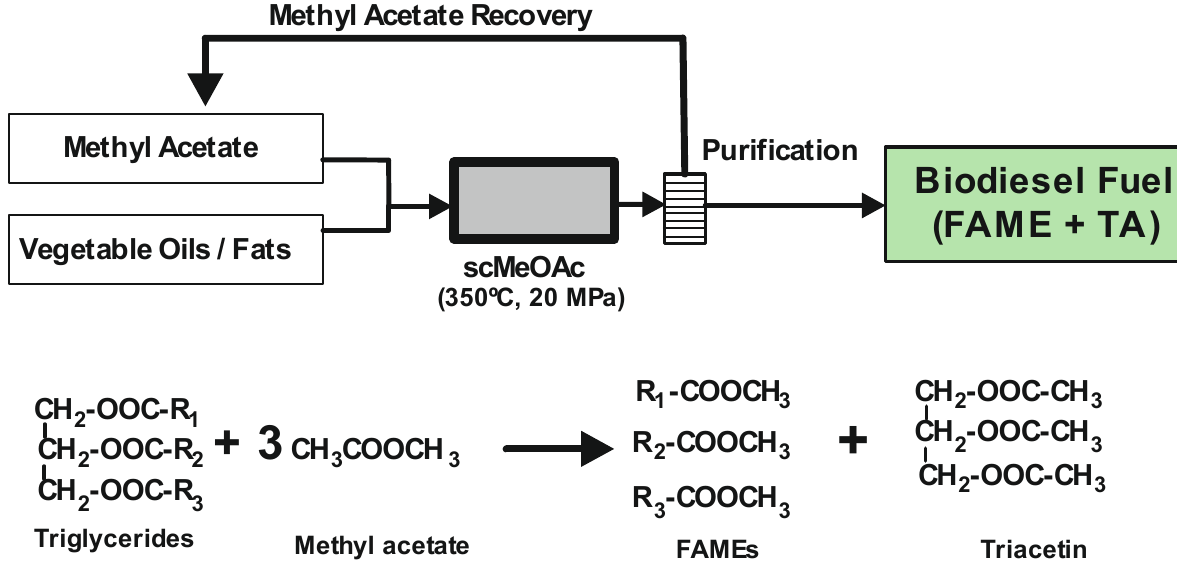
Figure 4. Biodiesel fuel synthesis using supercritical methyl acetate (scMeOAc). Reaction equations.